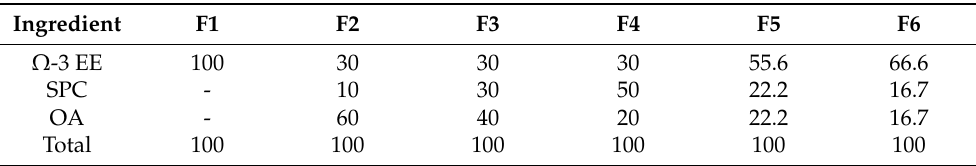
Table 1. SALC formulations (weight